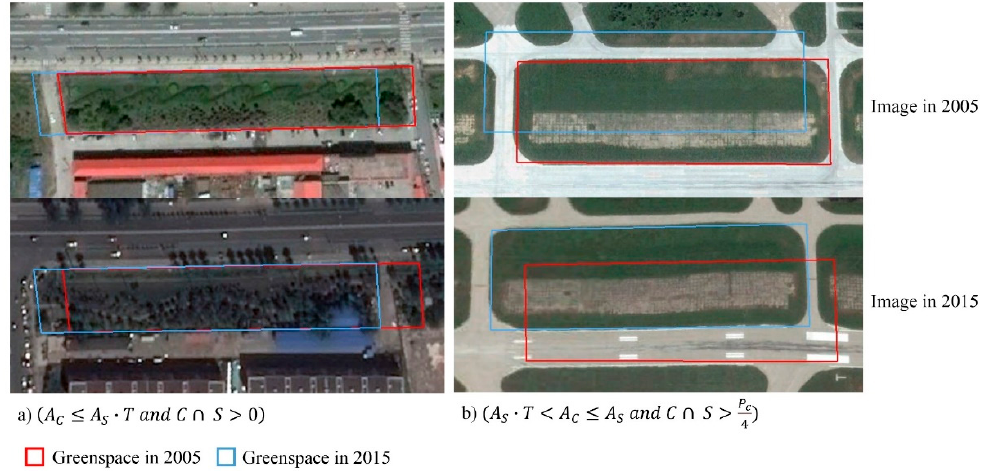
Figure 2. Schematic diagram of false-change recognition. ( a ) The identified “changed part” was small and shared some boundaries with the original patch; ( b ) the identified “changed part” was relatively large but no larger than the original patch. It shared more than a quarter of its boundary with the original patch. In the equations, C is the changed part; S is the original patch; A C is the area of the changed part; A S is the area of original patch; C ∩ S is the length of boundary shared by C and S ; T is a fraction indicating size threshold relative to A S ; and P c is the perimeter of C .